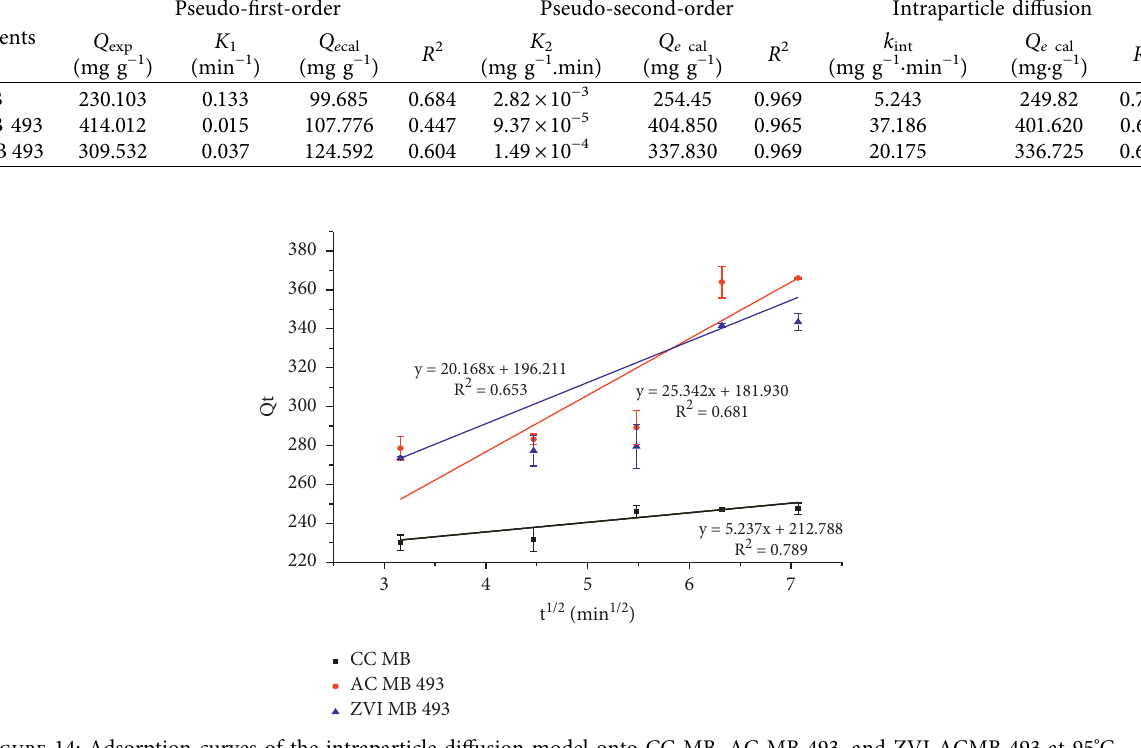
Figure 14: Adsorption curves of the intraparticle diffusion model onto CC MB, AC MB 493, and ZVI ACMB 493 at 95 °